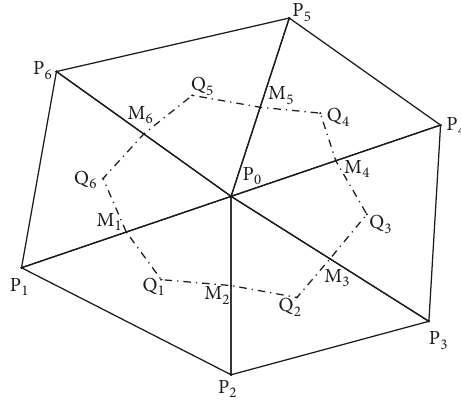
Figure 1: Control volume with barycenter as internal